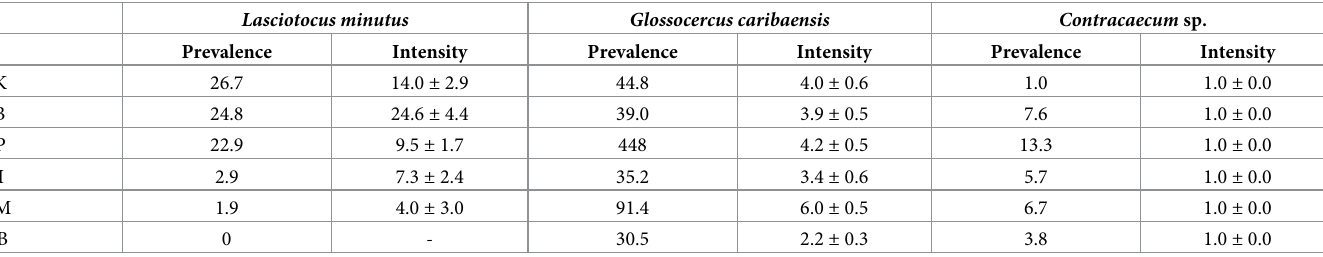
Table 4. Prevalence (%) and mean intensity (SE) of the 3 indirect life-cycle parasite taxa infecting the salt marsh fish, F . heteroclitus